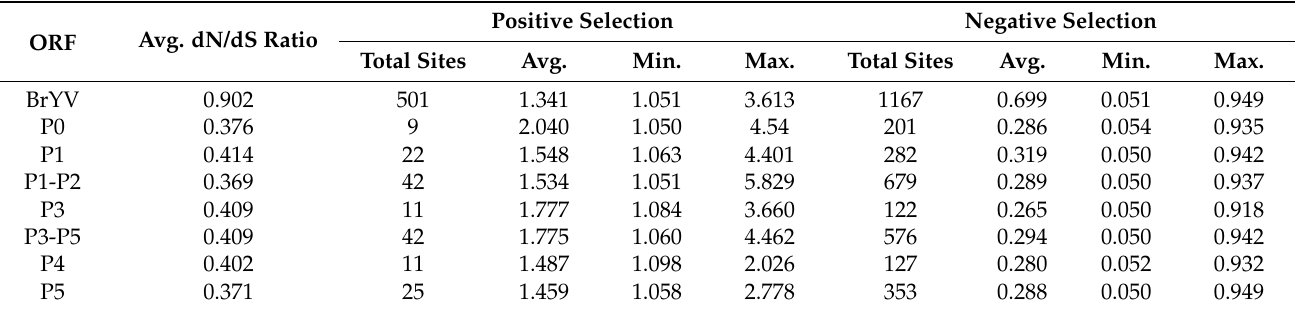
Figure 6. Percentage of sites evolving under negative/positive selection pressure. The datasets in ‐ clude ( A ) percentage of sites evolving under positive selection pressure in BrYV genome and its encoded genes and ( B ) percentage of negatively selected sites in BrYV genome and its encoded genes. Table 4. Estimation of average dN/dS ratios and positive and negative selection for coding se ‐ quences of BrYV.